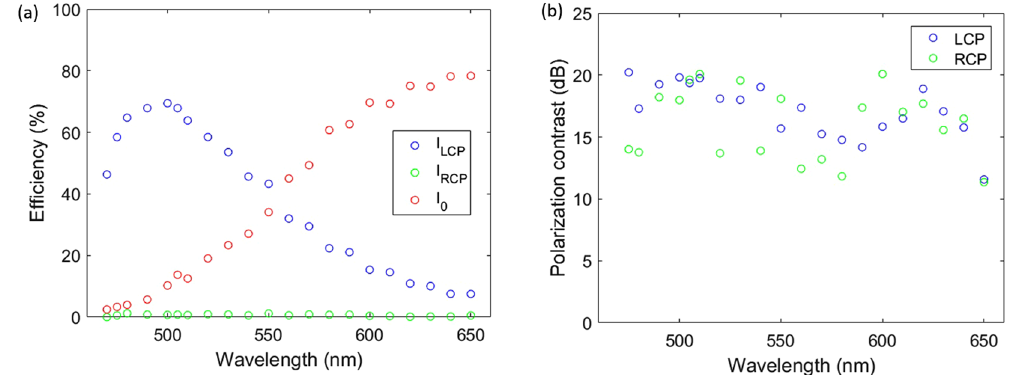
Figure 4. Broadband properties. ( a ) Focusing efficiency for LCP - RCP and 0th order coupling loss for LCP illumination at different wavelengths. The LCP focusing efficiency is peaked at 500 nm. The intensity in the 0th order increases gradually from to 0% to almost 80% in the wavelength range 470 nm to 650 nm. ( b ) The polarization contrast for RCP - LCP from 470 nm to 650